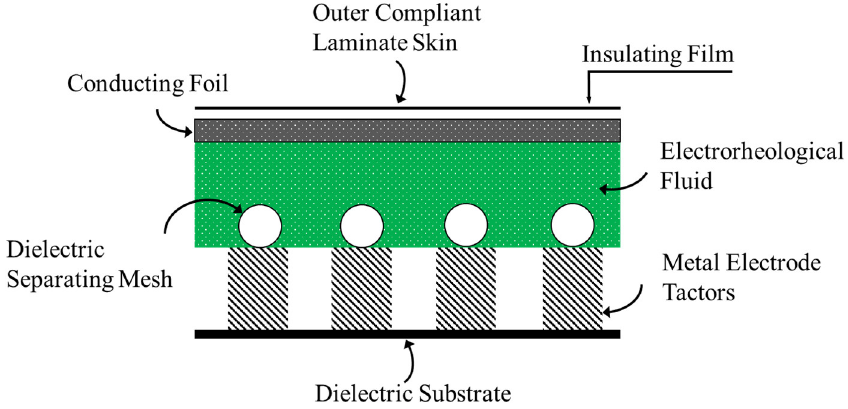
Figure 1. Tactile display featuring ERF